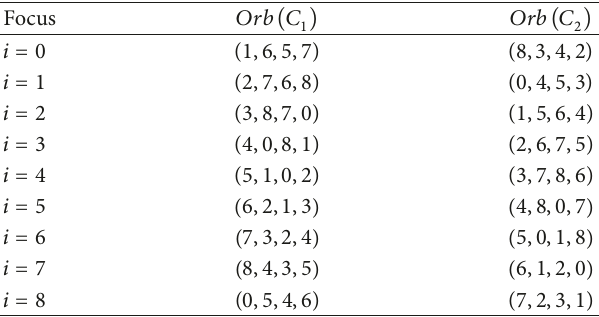
Table 2: A simple cyclic near-resolvable 4-cycle system of 2𝐾 9